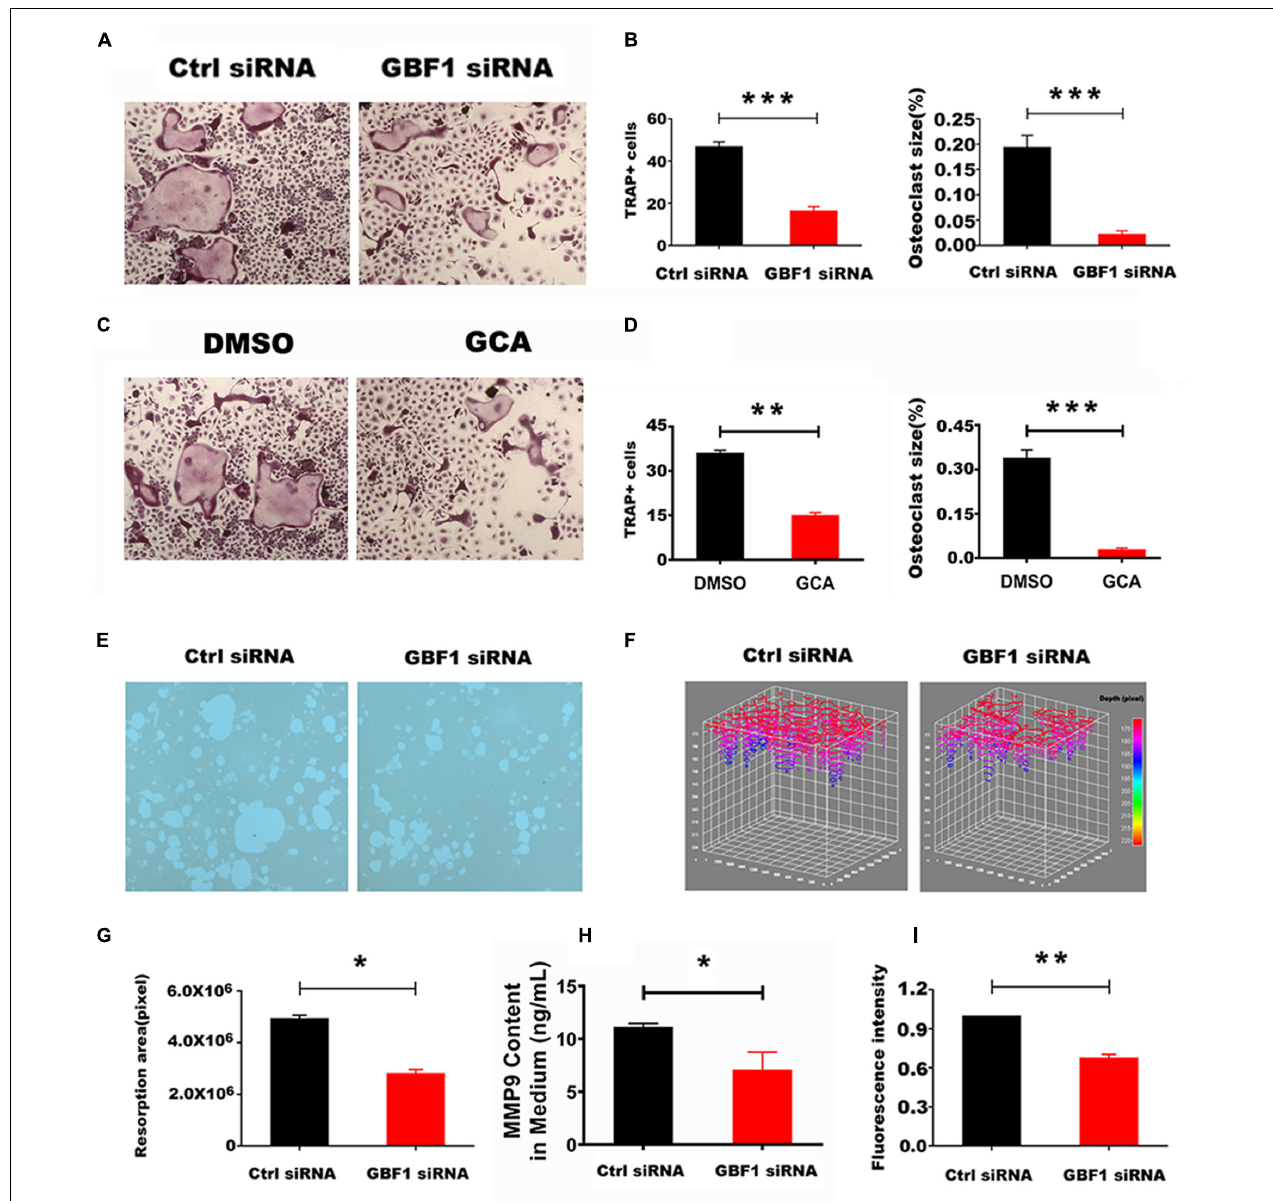
FIGURE 1 | Effect of GBF1 on osteoclast differentiation and function in vitro . (A,C) RAW264.7 cells were transfected with scrambled siRNA (NC) as control, or with GBF1 siRNA E11. Cells were cultured in the presence of RANKL (50 ng/ml) for 5–7 days, followed by TRAP staining (original magnification, × 5). (B,D ) TRAP-positive multinucleated osteoclasts (nuclei ≥ 3) were counted and the average size of osteoclasts was measured by Image-Pro-Plus 6 software. (E) RAW264.7 cells were cultured on Corning Osteo Assay Surface 96-well plates following the aforementioned method to observe the representative images of resorption pits (original magnification, × 5). (F) The area and depth of the resorptive hydroxyapatite-coated surface were recorded with stack 3D surface plot in Image-Pro-Plus 6 software. (G) The resorption area of the hydroxyapatite-coated surface was analyzed by Image-Pro-Plus 6 software. (H) The MMP9 content in OCs induced for 5–7 days in supernatant by ELISA assay. (I) Acid secretion was detected by acridine orange staining using a fluorescent microplate reader (Ex = 482 nm and Em = 588 nm). Data are expressed as mean ± SD. * p < 0.05; ** p < 0.01; *** p < 0.001. E11 transfections were compared with NC for statistical